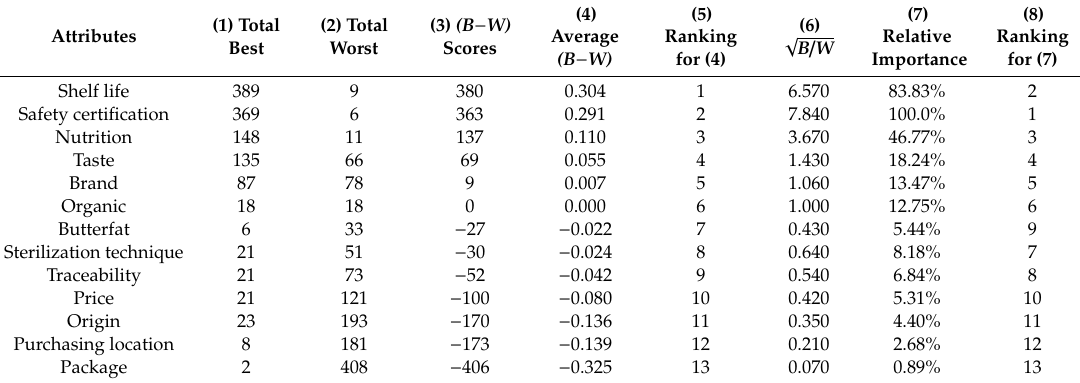
Table 3. Best–worst scores: attribute importance